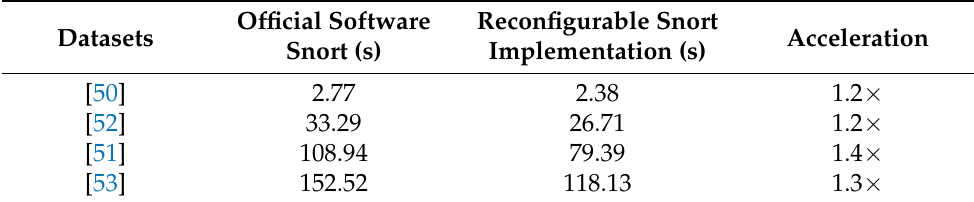
Table 2. Performance for the official fully-optimized Snort implementation framework vs. the reconfigurable Snort implementation on a PYNQ